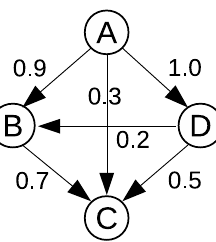
Figure 1. Example of a direct relation graph involving four